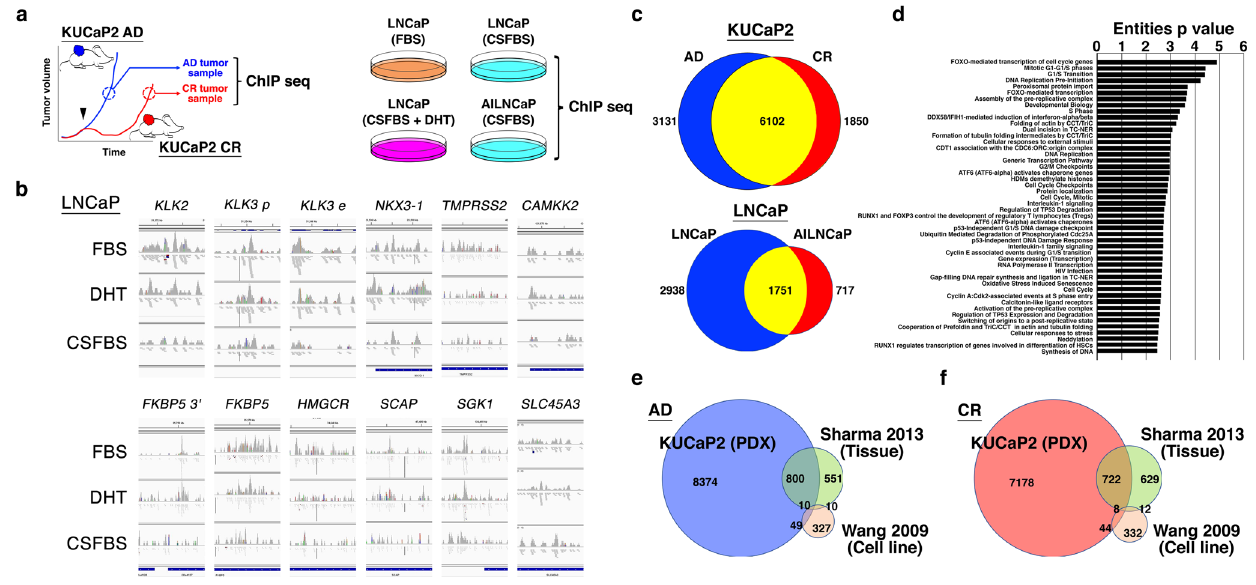
Fig. 2 Chromatin-immunoprecipitation sequence (ChIP seq) using antibody against androgen receptor (AR). a Top: Experimental schemes. KUCaP tumors under androgen-dependent (AD) and castration-resistant (CR) growth were obtained. Bottom: LNCaP cells cultured in FBS, charcoal-strip FBS (CSFBS) and CSFBS supplemented with 1 nM dihydrotestosterone (CSFBS + DHT) as well as AILNCaP cultured in CSFBS were subject to CHiP seq. b Quality controls for ChIP seq binding data. Bar fi les were generated after MAT analysis of AR whole-genome ChIP seq raw data from LNCaP cells cultured in FBS, charcoal-strip FBS (CSFBS), and CSFBS supplemented with 1 nM dihydrotestosterone (DHT). AR-binding peaks at the promoter regions (unless otherwise indicated) of indicated genes 13 are shown. KLK3 p; KLK3 ( PSA ) promoter, KLK3 e; KLK3 ( PSA ) enhancer, FKBP5 3' , 3' UTR region of FKBP5 . c Venn diagrams showing AR-binding sites in KUCaP2 AD and CR tumors (top), and LNCaP and AILNCaP cells (bottom). We identi fi ed 3131 differential AR-binding sites for KUCaP AD tumors, 1850 for KUCaP2 CR tumors, 2,938 for LNCaP cells, and 717 for AILNCaP cells, which were de fi ned as having fold change ≤ 0.5 or ≥ 2 compared with each counterpart. There were 6102 AR-binding sites commonly identi fi ed in KUCaP2 AD and CR tumors and 1751 in LNCaP and AILNCaP cells. d Reactome pathways for genes exclusively identi fi ed for KUCaP2 CR tumors annotated by AR-binding sites in AR-ChIP seq with regard to entities p -values ( − log[ p -value]). e , f Venn diagrams depicting differentially and commonly identi fi ed genes harboring AR-binding site in AD ( e ) and CR ( f ) models including PDX (the present study), human PCa tissue 22 , and cell lines 13